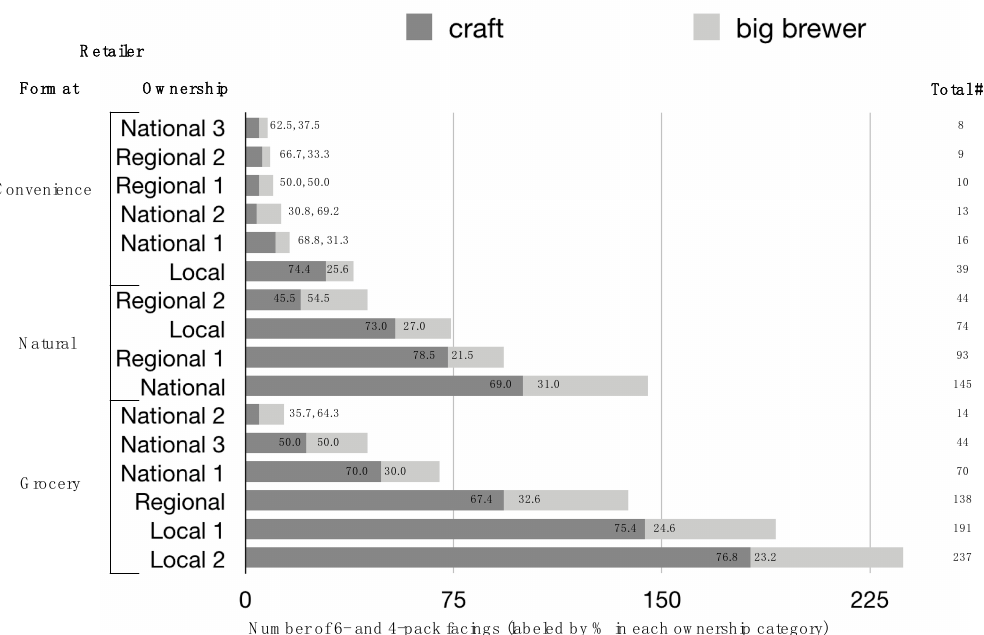
Figure 4. Ownership ties for “craft” beer facings ( n = 1145) at sixteen retailers in Lansing, MI, USA.